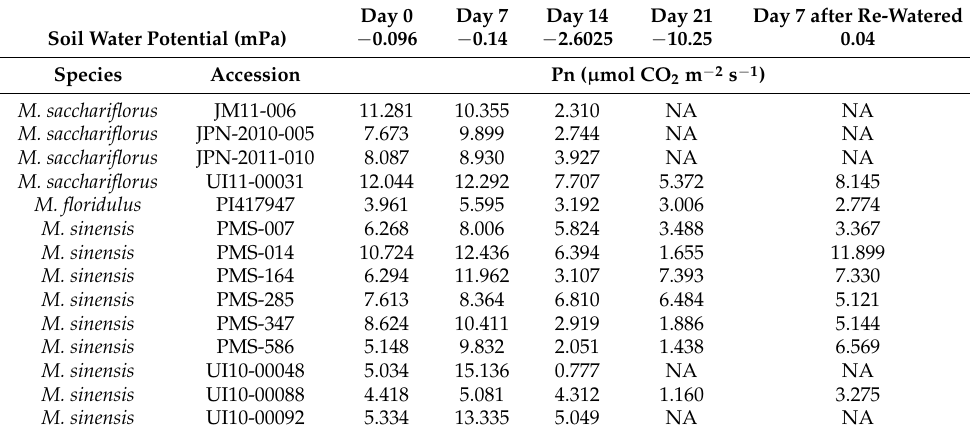
Table 4. Photosynthetic rate (Pn) of each Miscanthus genotype under each soil water potential in a screening experiment and a post-drought recovery experiment at Brigham Young University, Provo, Utah,